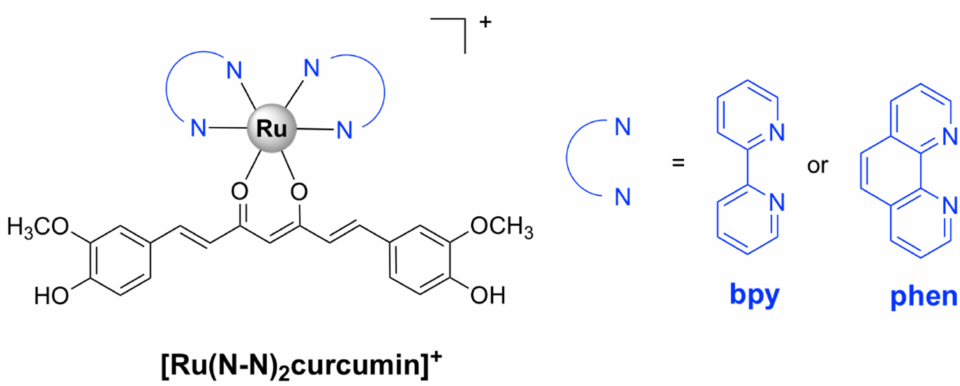
Figure 5. [Ru(N-N) 2 curcumin] + , where N-N is either 2,2’-bypiridine (bpy) or 1,10-phenanthroline (phen).